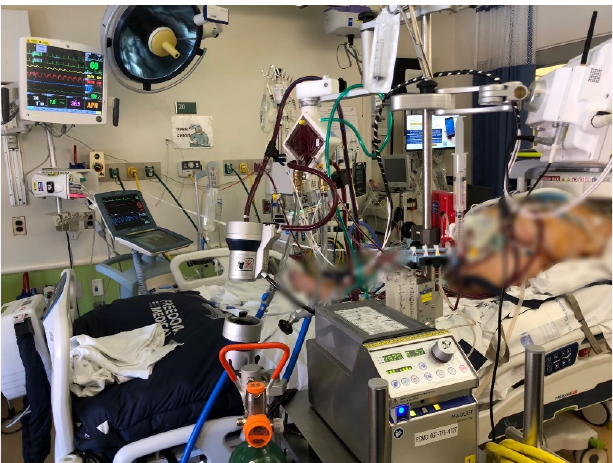
Figure 1. Patient with ECMO support within the Swoop ® scanner. ECMO and IABP console were